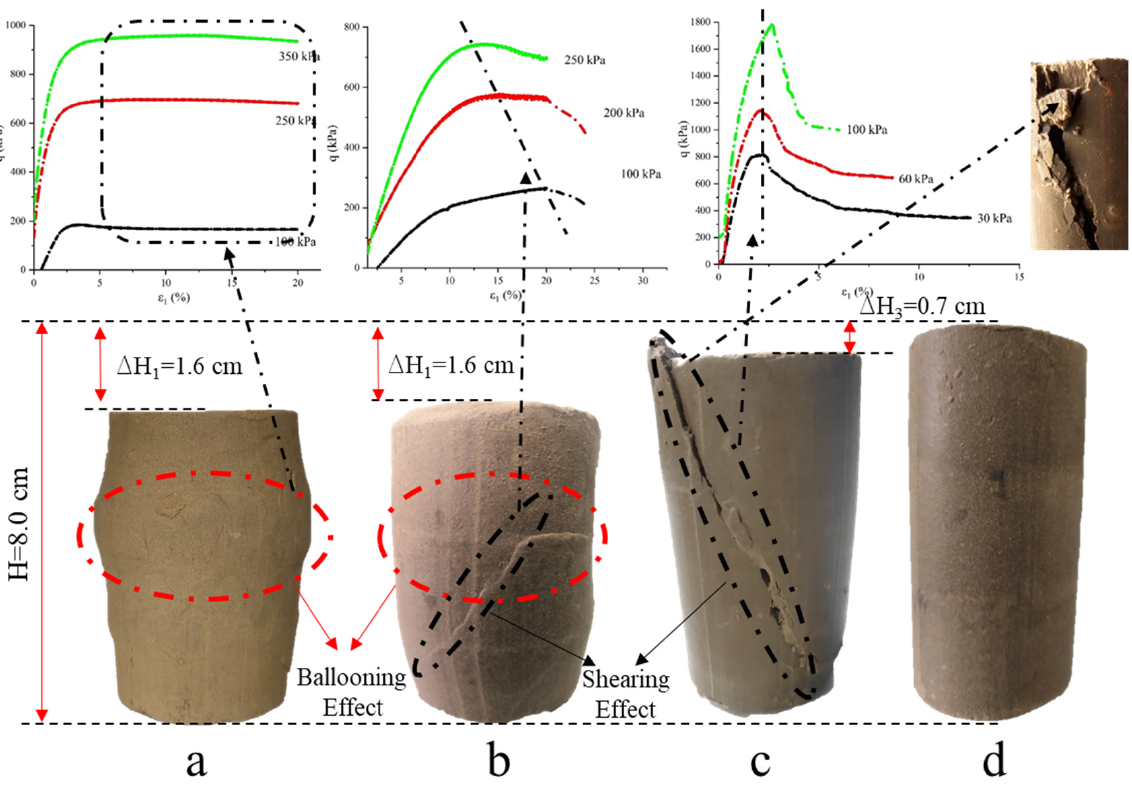
Figure 11. The failure mode of specimen in the shear test: ( a ) pure loess specimen; ( b ) attapulgite- lime-modified loess specimen; ( c ) attapulgite-cement-modified loess specimen; ( d ) original contrast specimen.